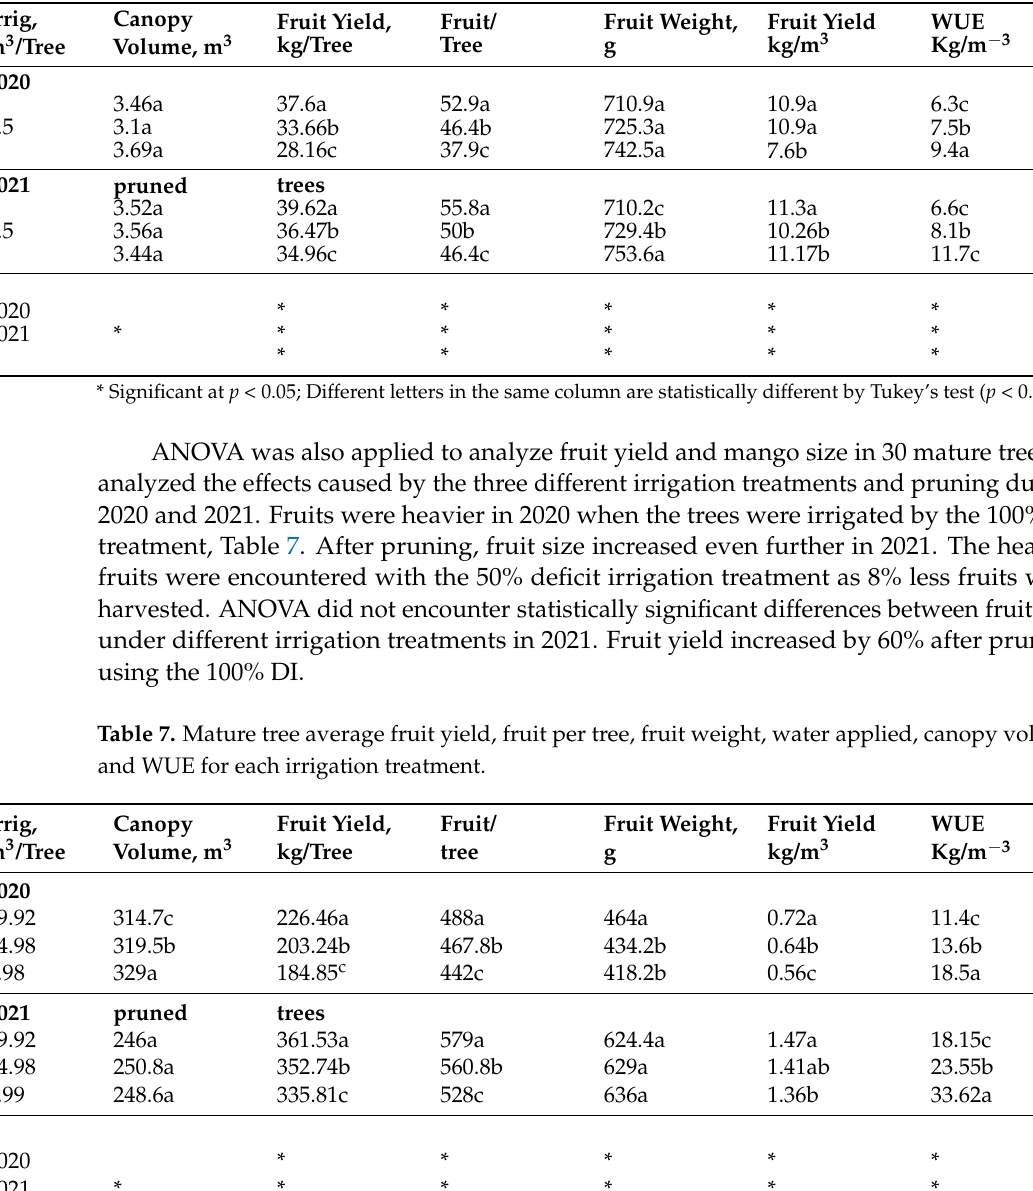
Table 6. Average fruit yield, fruit per tree, fruit weight, water applied, canopy volume and WUE for each irrigation treatment during 2020 and 2021 for HD trees.